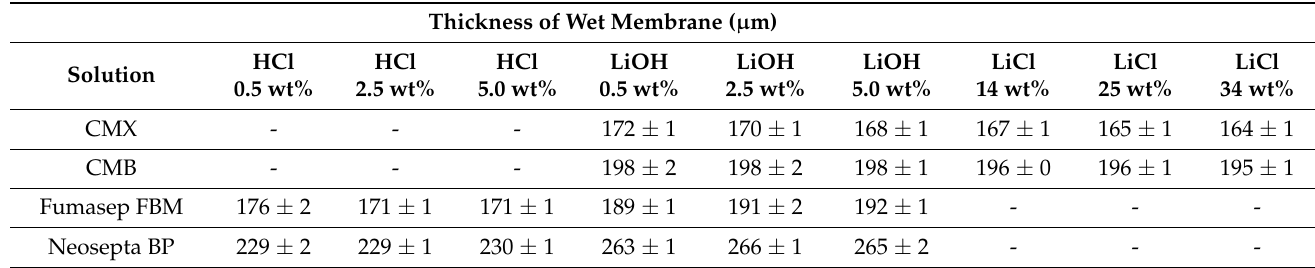
Table 7. Wet membrane thickness measured in cation-exchange and bipolar membranes. Thickness of Wet Membrane ( µ